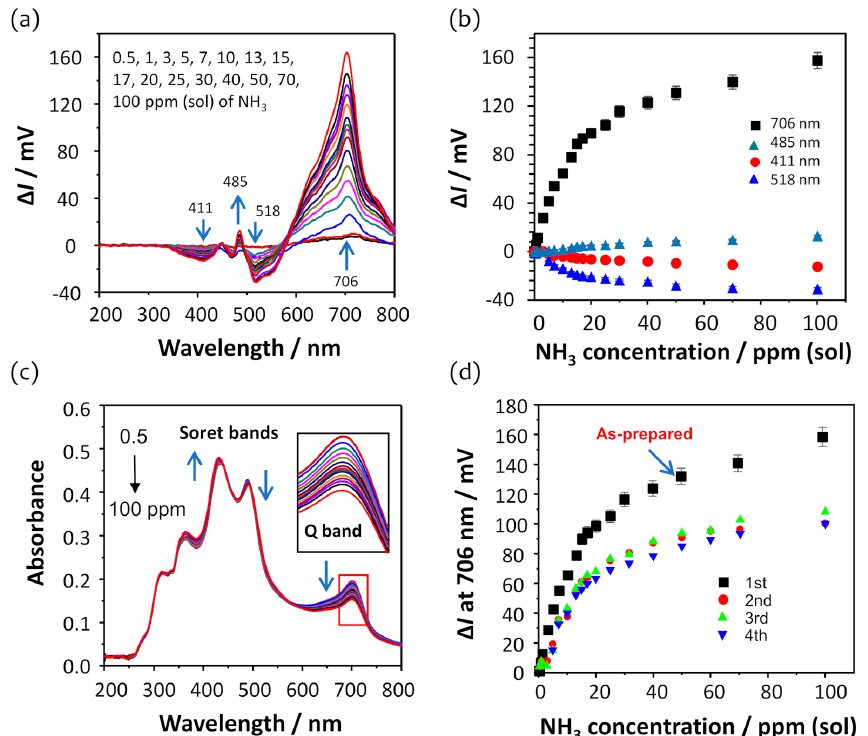
Figure 3. ( a ) Evolution of the transmission spectra induced by the exposure of the U-bent OFS modi- fied with a 5-cycle DAR/TSPP+PSS (0.025 wt%) film to ammonia concentrations from 0 to 100 ppm (sol). ( b ) The intensity changes at four different wavelengths versus ammonia concentration, ob- tained from the three independent experiments conducted using the individual as-prepared sensors fabricated under the same conditions. ( c ) The corresponding UV-vis absorption spectral changes due to the exposure of the film to ammonia. The inset shows the decrease in absorbance of the Q band centered at 706 nm induced by the presence of ammonia. ( d ) The intensity changes at 706 nm, obtained from the four consecutive ammonia